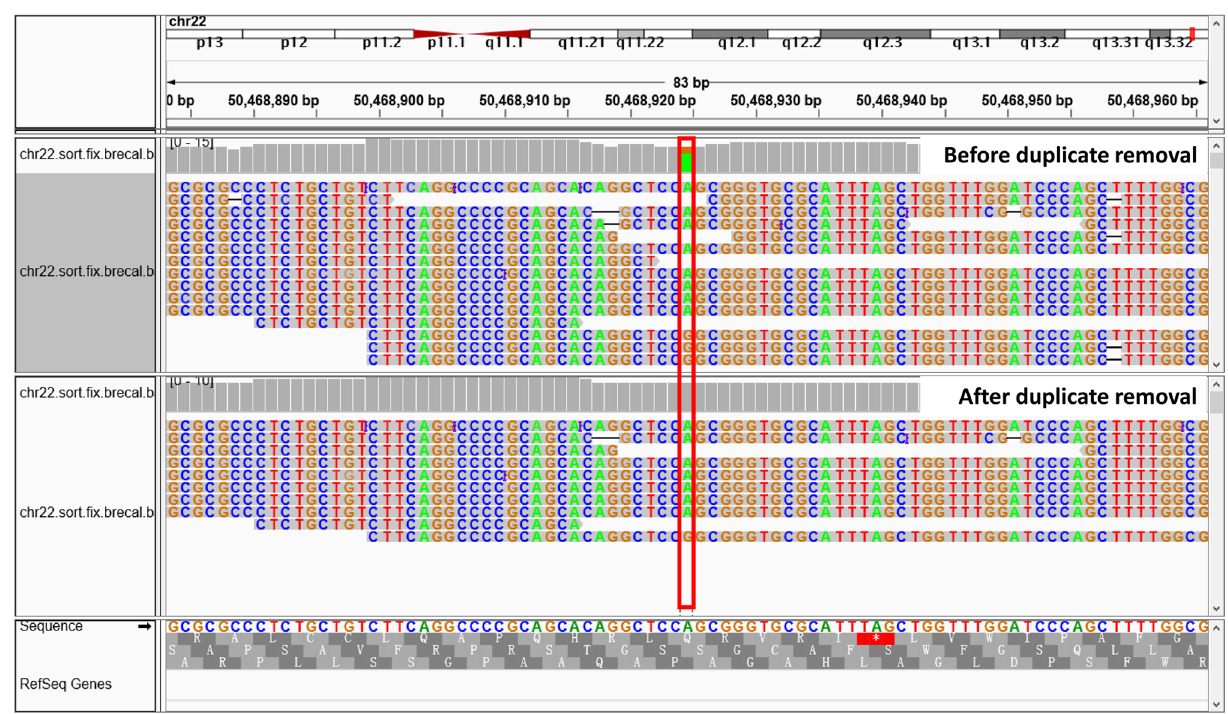
Figure 2. Reads distribution before and after RDAST treatment. The position in the red box, ischr22:50468925, for which three reads of genotype G make up 27.27% of the results, will show up as a false positive site. However, after RDAST treatment, two reads are deleted, and the remaining read accounts for 12.5% of all reads in this position. Consequently, this false positive result disappears.